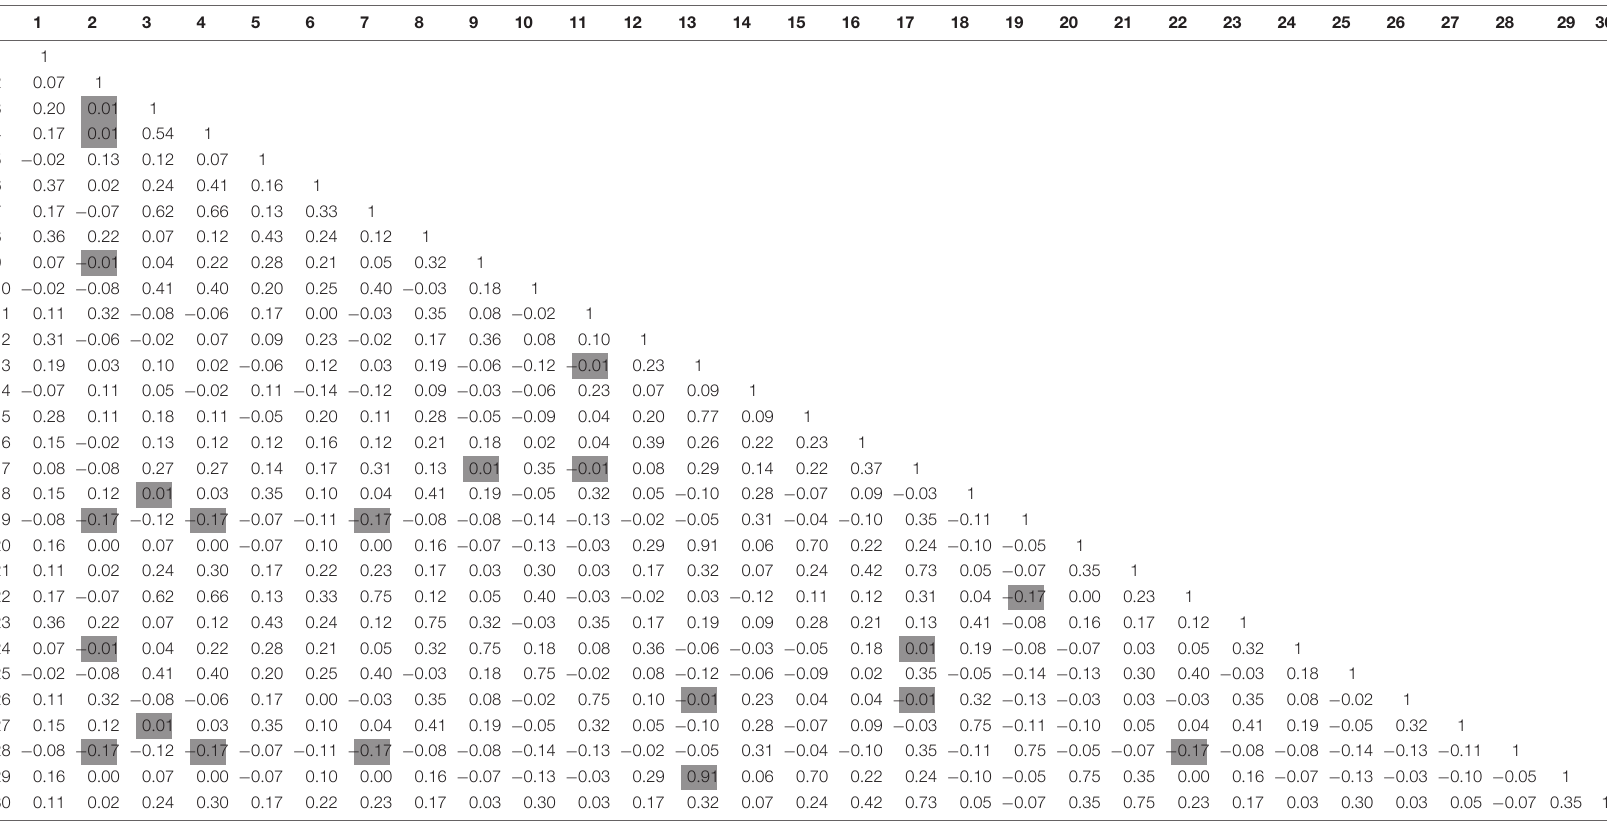
Key: 1 = 163,310; 2 = 18,649; 3 = 18,650; 4 = 18,654; 5 = 18,655; 6 = 30,518; 7 = 30,526; 8 = 32,122; 9 = 32,618; 10 = 30,802; 11 = 19,339; 12 = 419,218; 13 = 508,504; 14 = 227,230; 15 = 647,853; 16 = 647,858; 17 = 163,309; 18 = 379,549; 19 = 212,119; 20 = 321,020; 21 = 604,785; 22 = 266,926; 23 = 261,789; 24 = 181,964; 25 = 179,593; 26 = 227,383; 27 = 648,942; 28 = 648,944; 29 = 184,379; 30 = 171,860. Highlighted values represent maximum and minimum correlation coefficient among